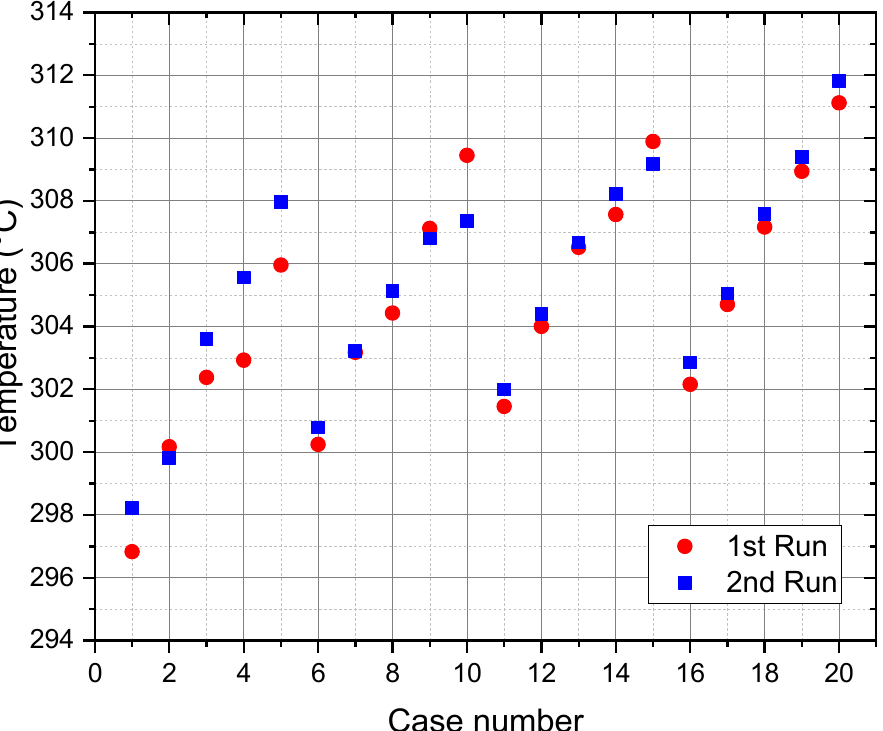
Figure 8. Measured temperature values at the mass flow meter.